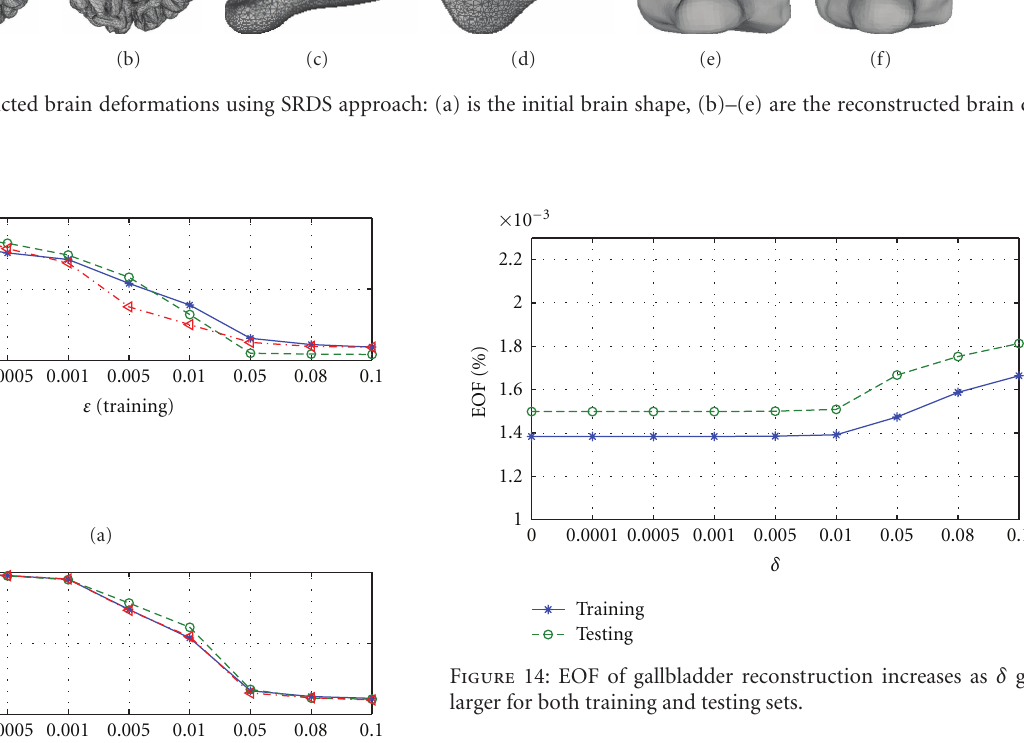
C. E ff ect of ε . The performance of SRDS algorithm is exam-